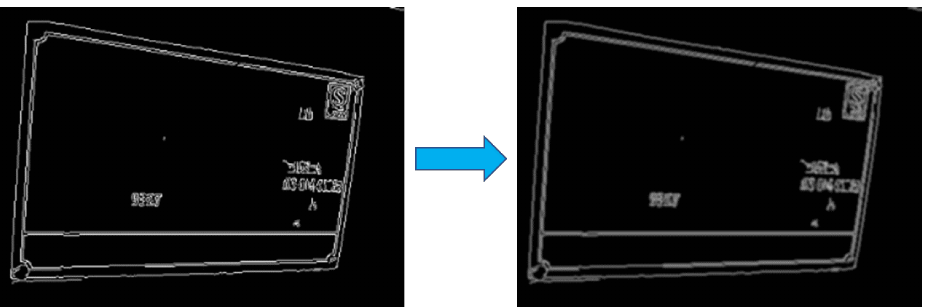
Figure 6. After edge detection, a Gaussian smoothing filter is applied to improve the accuracy of the resulting line segments. The left line segment appears straighter after the smoothing filter is applied, which helps to achieve more accurate results.